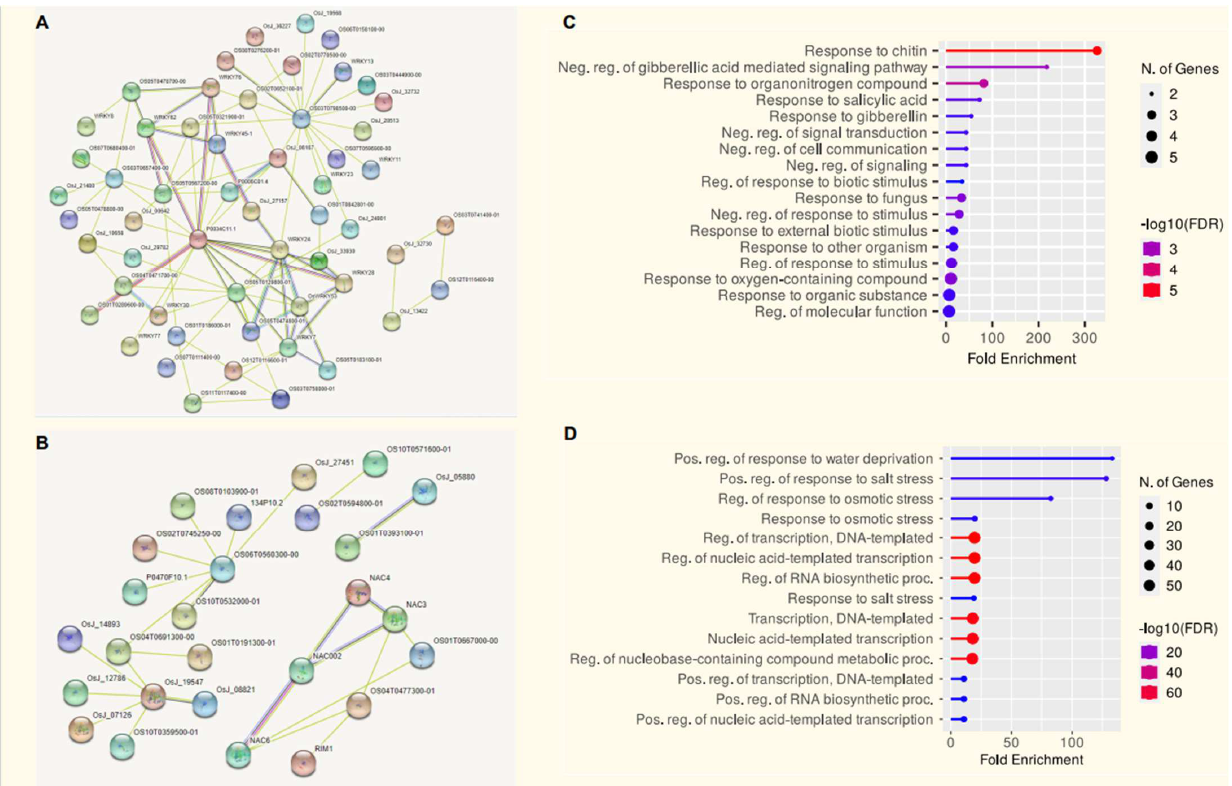
Figure 7. ( A ) Protein–protein association network of the OsWRKY genes based on their available information. The online tool STRING was used to predict the entire network. Different line colors represent the types of evidence for the associations, which are shown in the legend. ( B ) Protein– protein association network of the OsNAC genes based on their available information. The online tool STRING was used to predict the entire network. Different line colors represent the types of evidence for the associations, which are shown in the legend. ( C ) Gene ontology (GO) enrichment of the OsWRKYs . The sizes of circles indicate the number of genes in each category, while x -axis bars indicate fold enrichment. ( D ) Gene ontology (GO) enrichment of the OsNACs . The sizes of circles indicate the number of genes in each category, while x -axis bars indicate fold